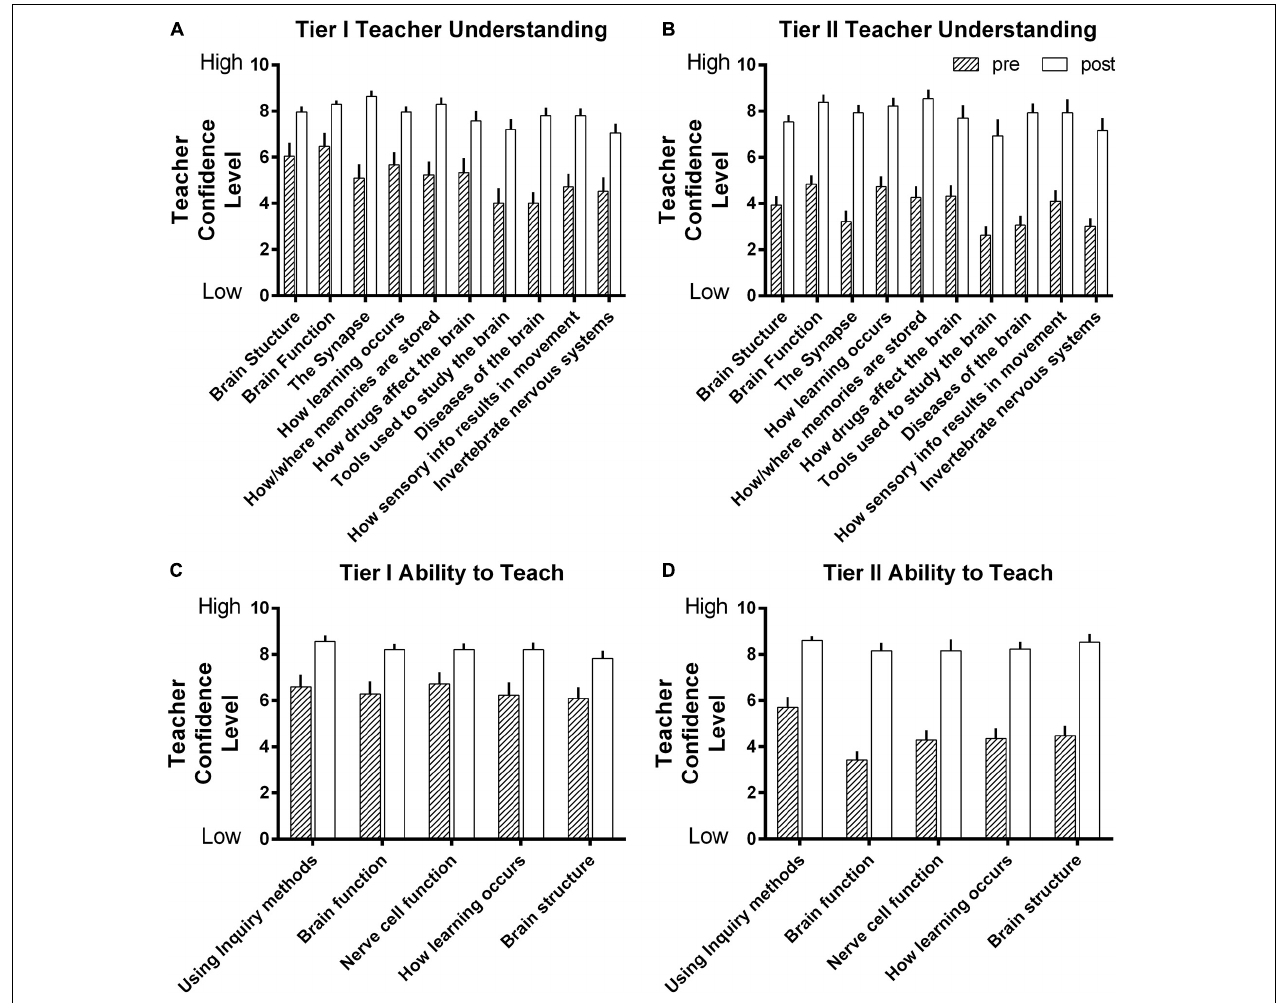
FIGURE 1 | Teachers’ self-confidence ratings on their knowledge of neuroscience (A,B) and their ability to teach neuroscience (C,D) . Both Tier I (A,C) and Tier II (B,D) teachers significantly increased their self-confidence on all content items (Bonferonni post-tests all p < 0.05 or better after two way ANOVAs: (A) p < 0.0001 pre to post, p < 0.001 for item, ns interaction. (B) p < 0.0001 pre to post, p < 0.05 for item, ns interaction. (C) p < 0.0001 pre to post, ns for item, ns interaction. (D) p < 0.0001 pre to post, ns for item, ns interaction). Bars are mean + sem; Tier I N = 21 pre, 24 post, Tier II N = 37 pre, 13